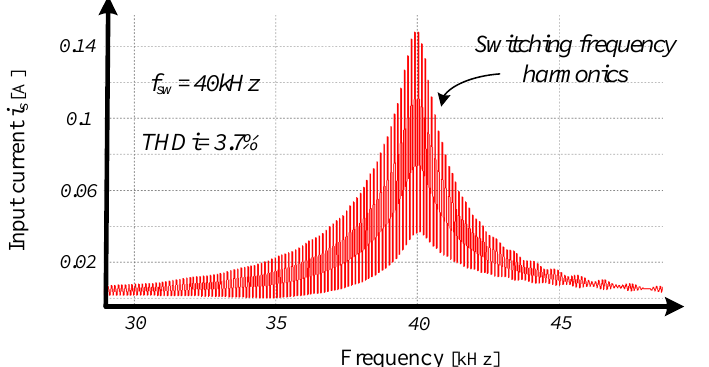
Figure 16. Frequency spectrum of the AC current using the adaptive hysteresis